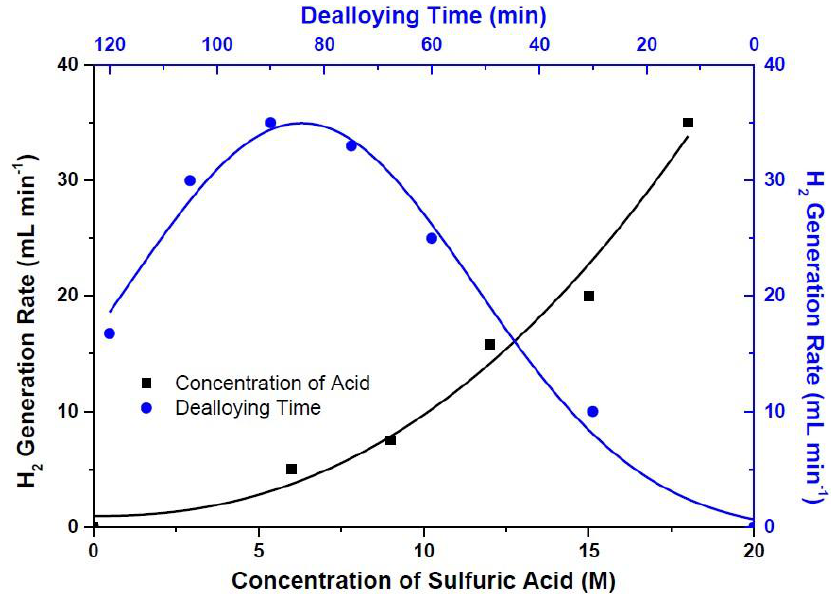
Figure 4. Influence of acid concentration (sputtering power of Ru and Cu and sputtering time are 50 and 200 W and 60 min, respectively, and dealloying time was 60 min) and dealloying time (sputtering power of Ru and Cu and sputtering time are 50 and 200 W and 60 min, respectively, and the acid concentration is 18 M) on hydrogen generation rates. Table 1. Ru and Cu content at various dealloying times (the sputtering powers of Ru and Cu were 50 and 200 W, respectively, while the sputtering time and sulfuric acid concentration were 60 min and 18 M, respectively, and results have been obtained via energy dispersive X-ray (EDX) analysis). Dealloying Time Catalysts Catalysts Bare